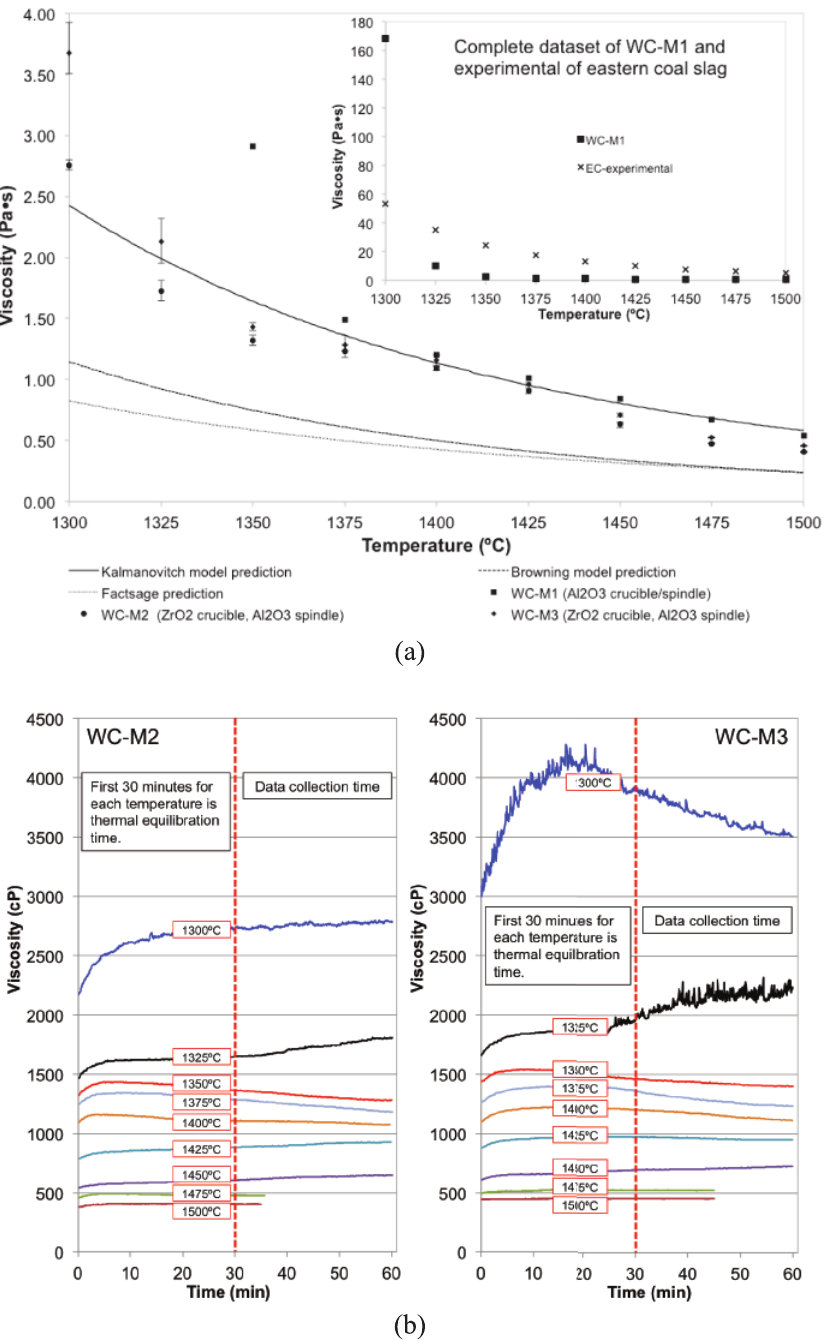
Fig. 2: (a) Measured viscosity vs. temperature and (b) Measured viscosity vs. time at the various